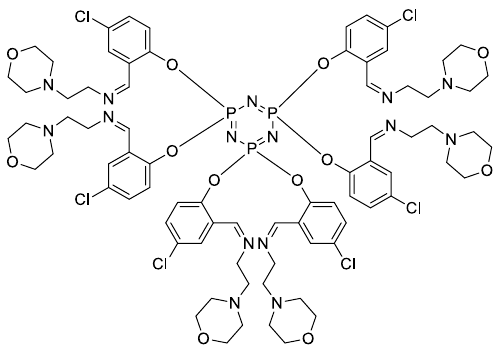
Figure 15. Molecular structure of compound 19c [59].